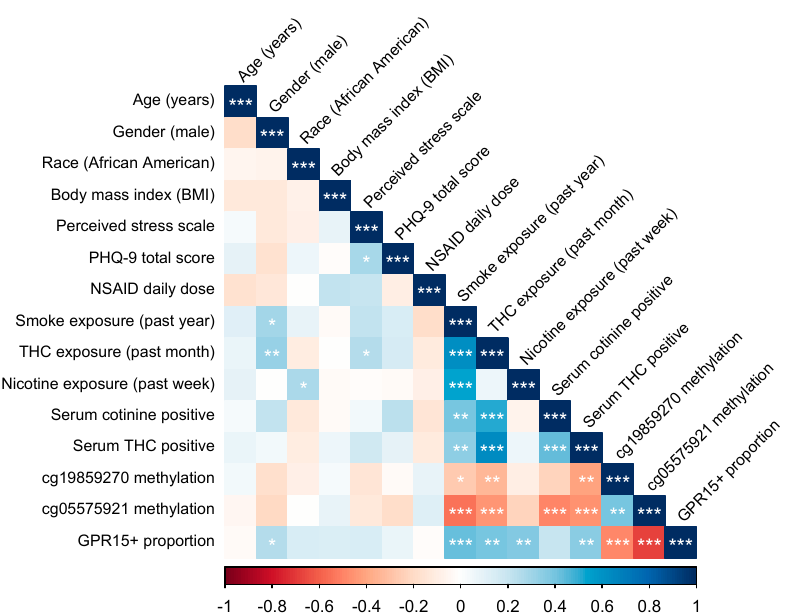
Figure 1. Correlations between study variables analyzed. BMI refers to body mass index. Perceived Stress Scale refers to the Perceived Stress Scale total score. PHQ-9 refers to the Patient Health Questionnaire depression module total score. Nonsteroidal anti-inflammatory drug (NSAID) daily dose refers to 200 mg equivalent doses of ibuprofen, naproxen, and aspirin. Smoke exposure indicates tobacco and/or cannabis smoking. Serum cotinine positive indicates serum values of > 1 ng/mL, while serum tetrahydrocannabinol (THC) positive indicates > 0.5 ng/mL. GPR15+ proportion refers to the proportion of CD3+CD4+ PBMCs. Significance codes: * p ≤ 0.05; ** p ≤ 0.01; *** p ≤ 0.001.